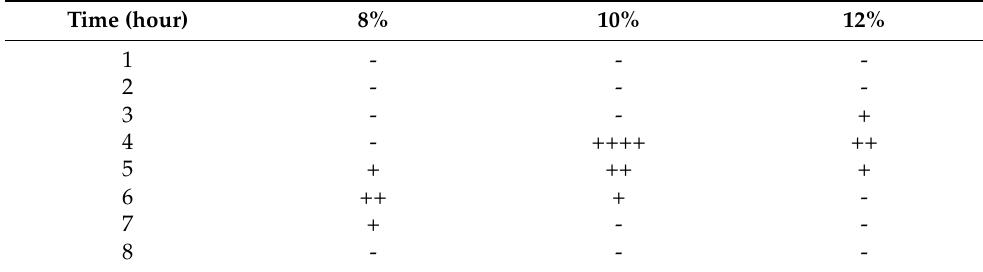
Table 1. Effect of agarose concentrations on the success rate of tTCL sections at 100 μm.